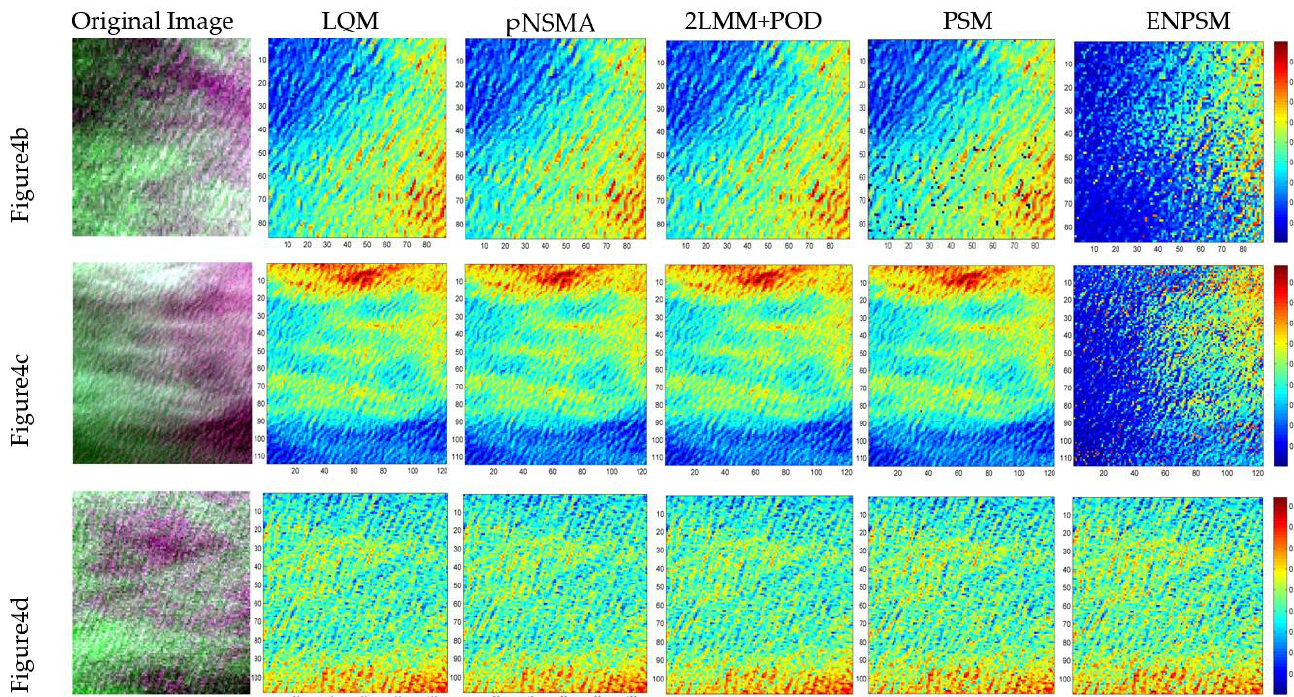
Figure 8. RGB composite of oil spill scenes in Figure 4b–d and estimated oil abundance distribution maps derived from LQM, pNSMA, 2LMM with POD, PSM, and ENPSM, respectively. Table 5. RE results delivered by five unmixing method over Figure 4b–d with endmembers derived by means of maximum volume simplex analysis (MVSA) extraction algorithm [17]. The best results are highlighted in bold.